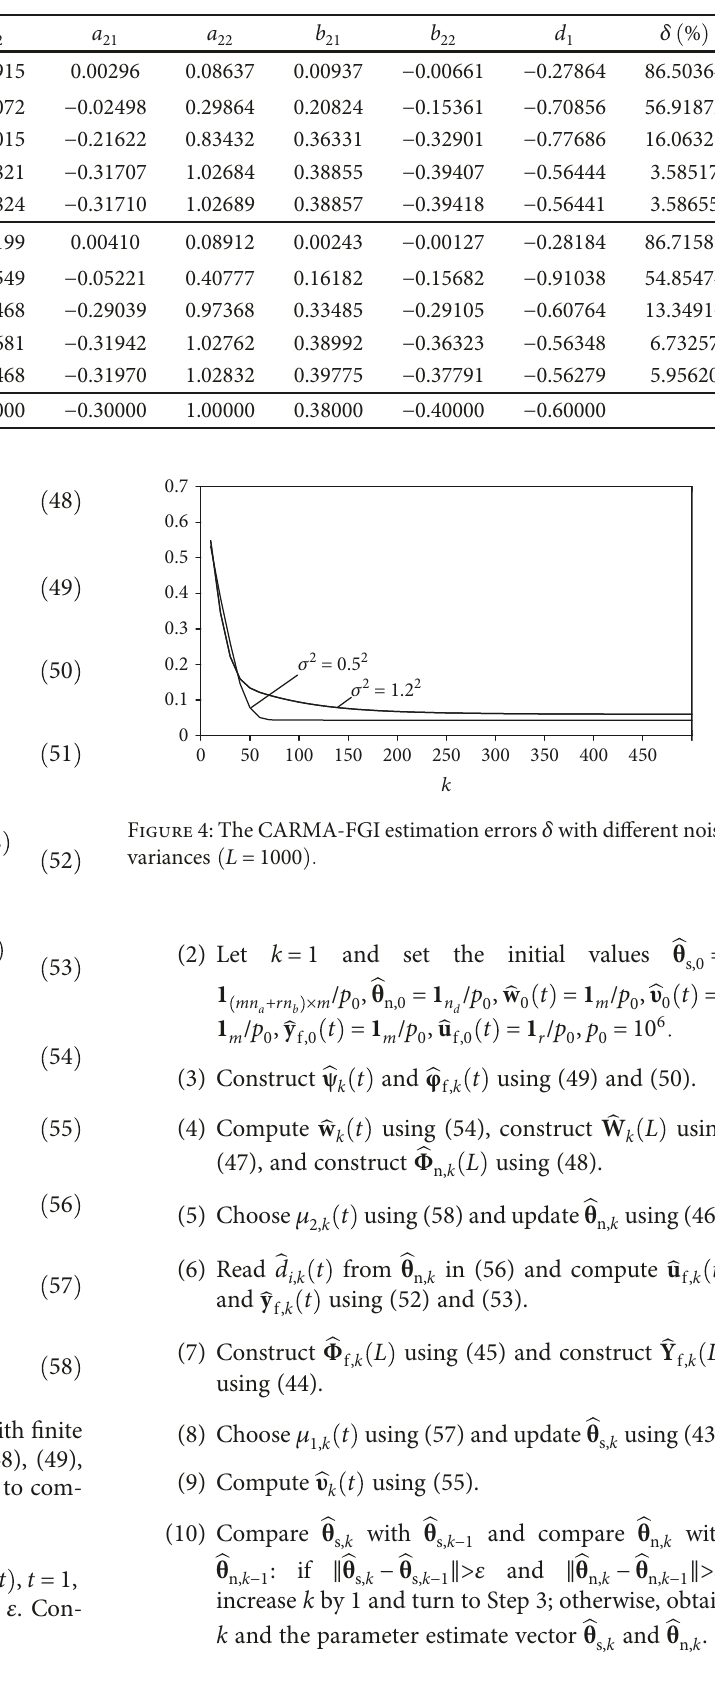
Table 1: The F-GI parameter estimates and errors ( L = 1000 ).